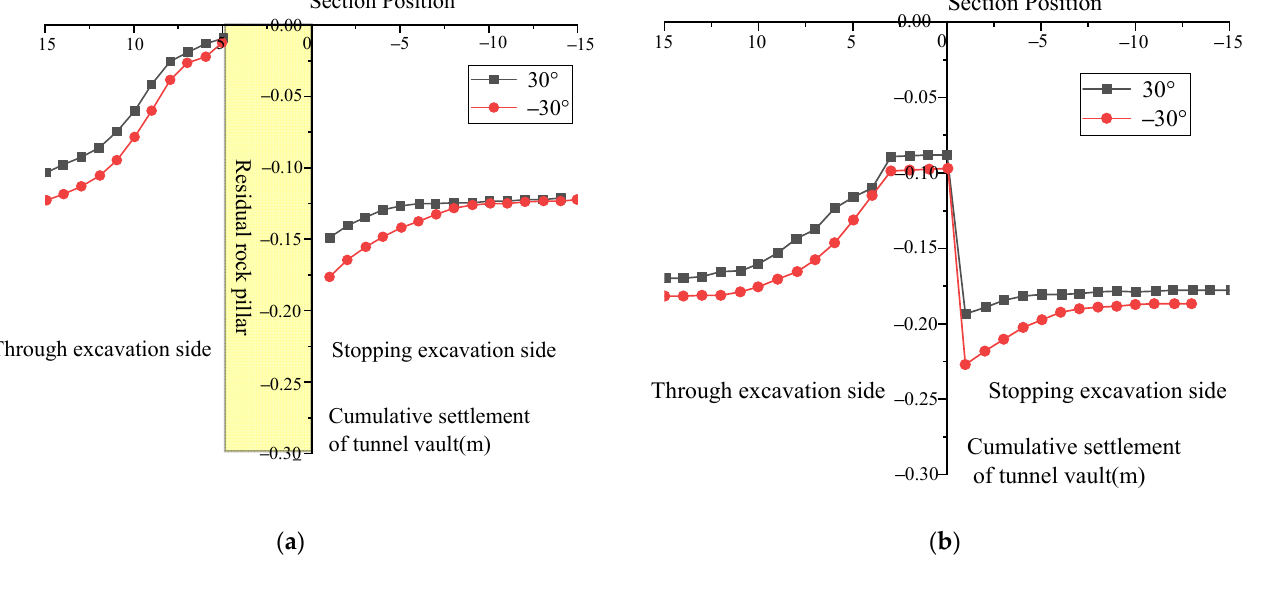
Figure 13. y = 50 m, cumulative vault settlement of the tunnel: ( a ) Retained rock mass pillar and ( b ) excavated rock mass pillar